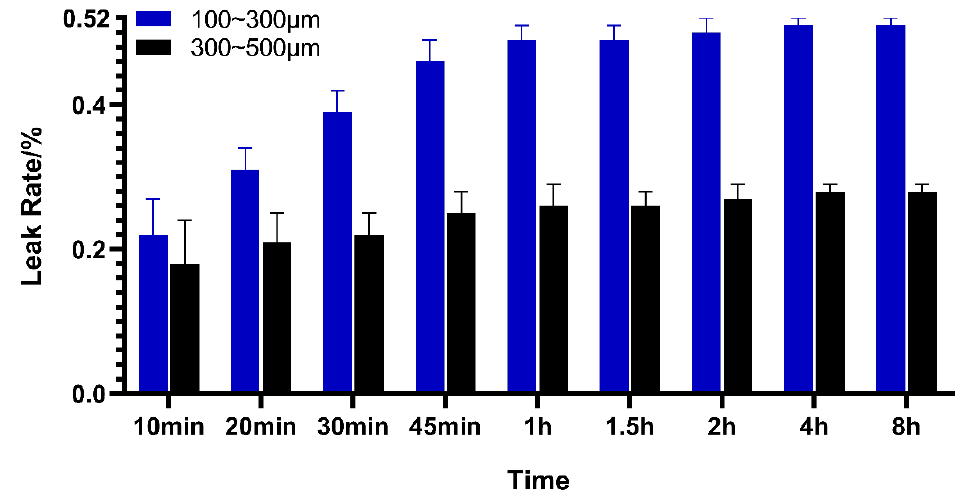
Figure 2. IDA leak rate after compatibility with iopamidol ( n = 3).